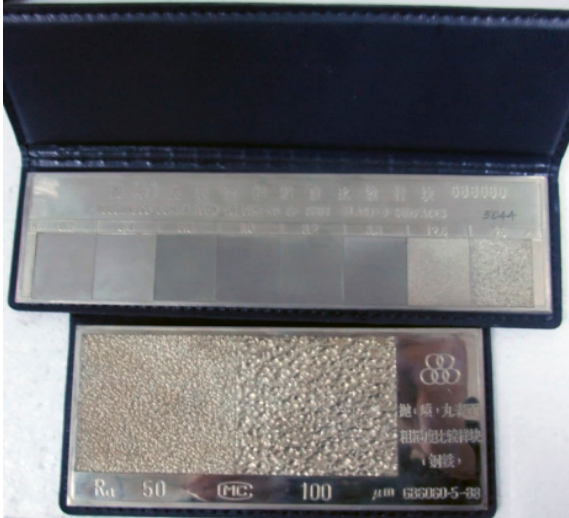
Figure 7. The samples with different surface roughness (material = SS).